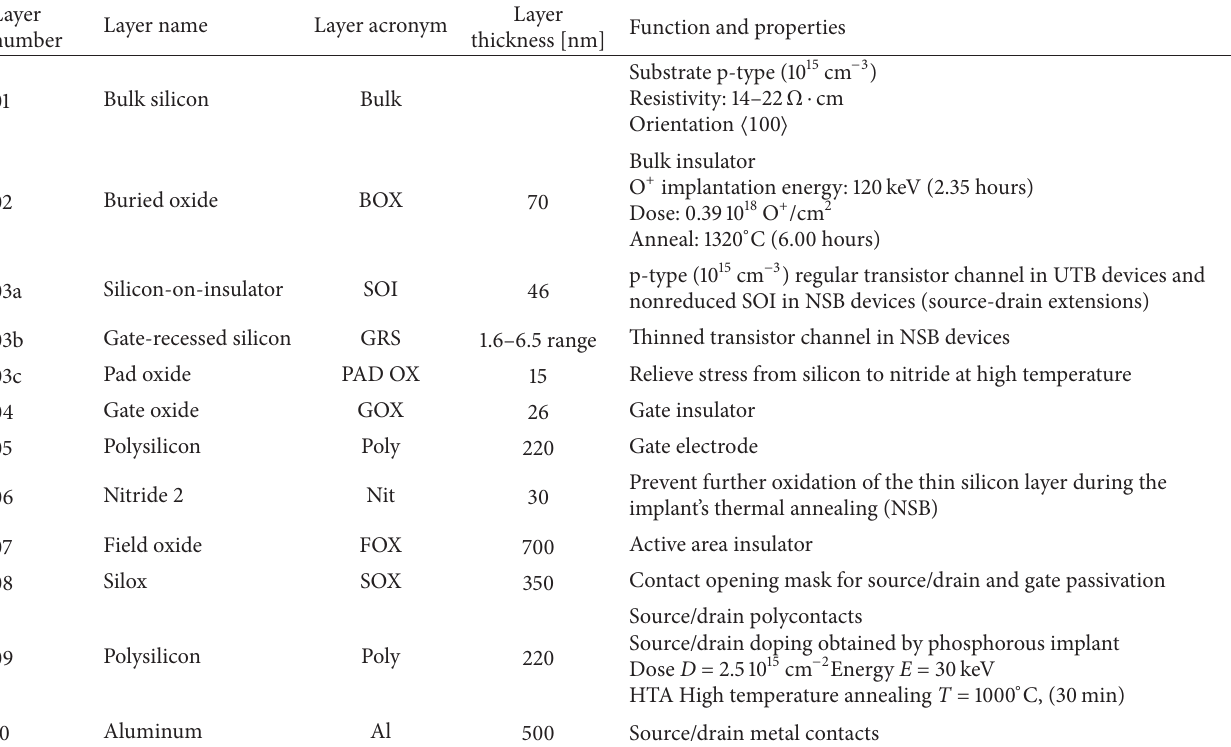
Table 1: Process parameters for deposited layers.